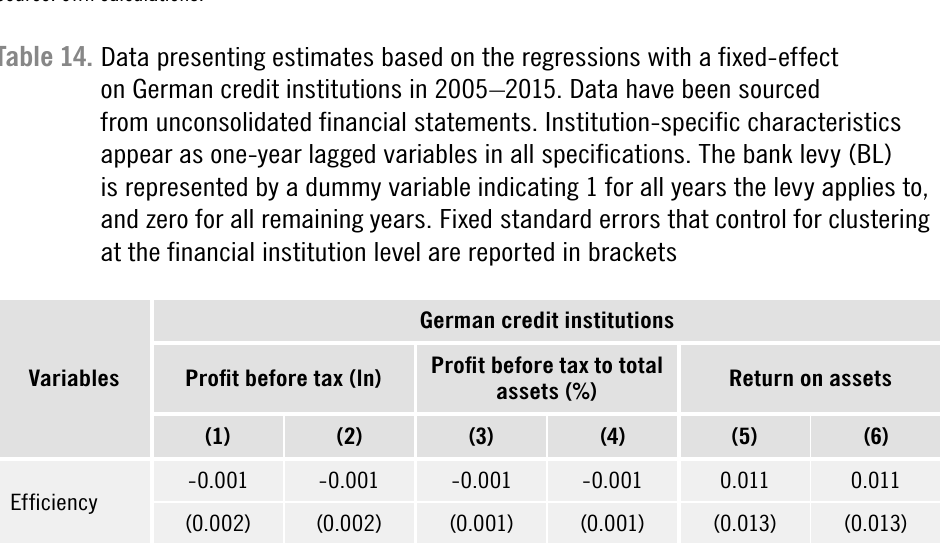
Table 14. Data presenting estimates based on the regressions with a